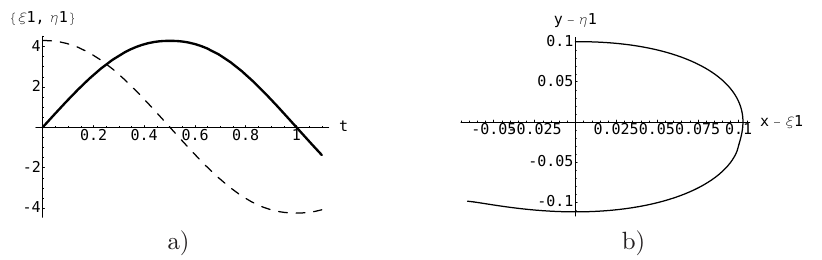
Figure 3. 1 -type solution ( ξ 1 ( t ) , η 1 ( t )) of the problem (5.1): a) initial data ξ 1 (0) = 0 , η 1 (0) = 4 . 2886 ; b) phase portrait of the difference between neighboring solution ( x ( t ; δ ) , y ( t ; δ )) and ( ξ 1 ( t ) , η 1 ( t )) , t ∈ [0 , 1] , if δ = 0 . 1